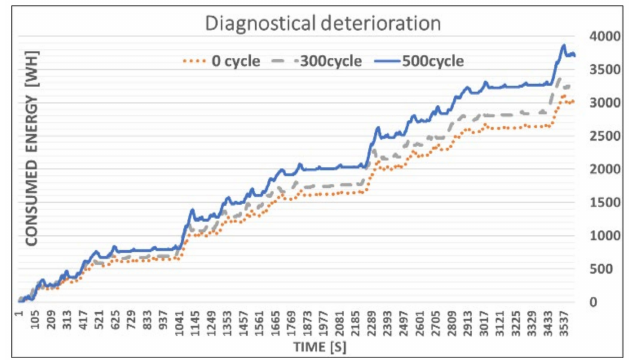
Figure 29. Required energy for di ff erent number of cycle operation